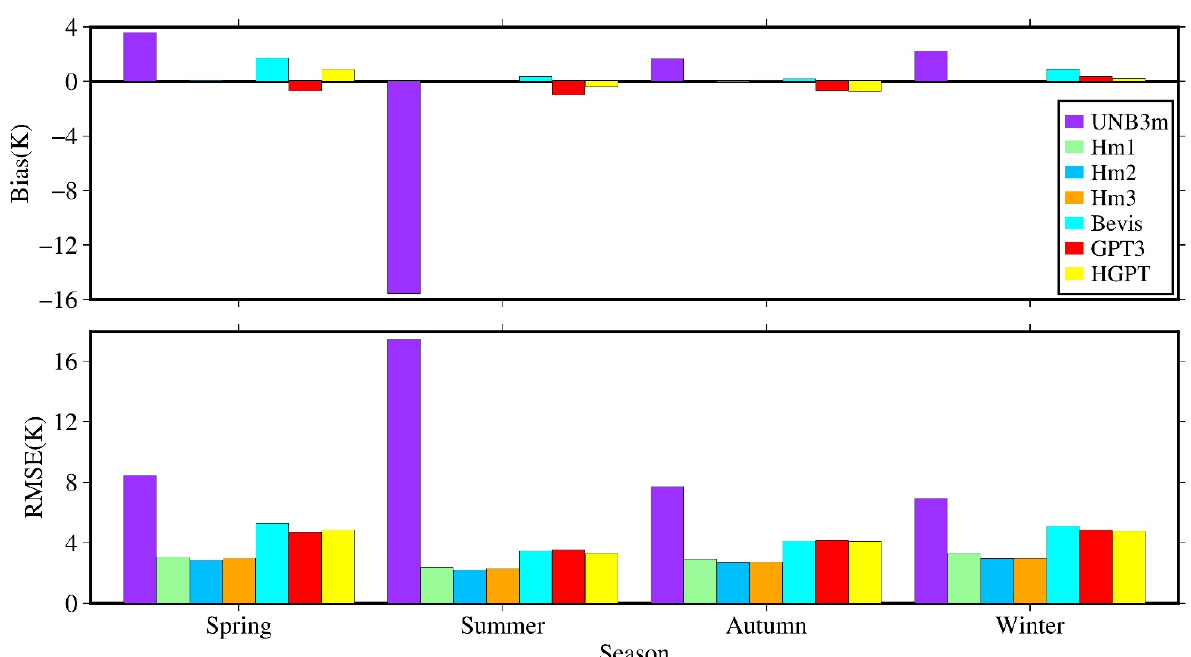
Figure 12. Biases and RMSEs of each model in different seasons.